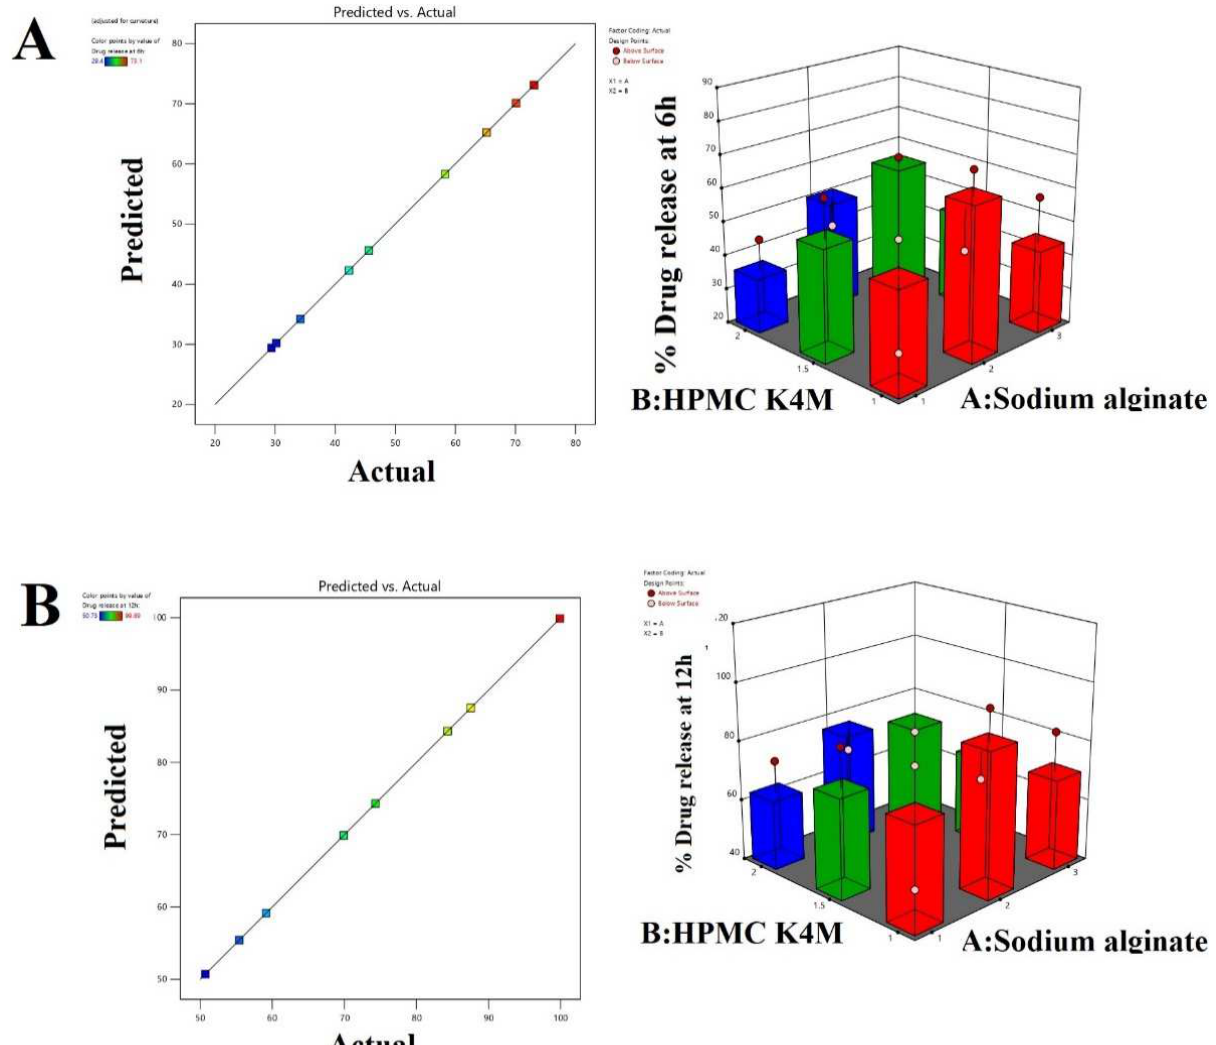
Figure 7. Predicted and actual value plots and 3D response surface plots showing the effect of the independent variables, i.e., factor A (sodium alginate) and factor B (HPMC K4M), on response % drug release at 6 h ( A ) and % drug release at 12 h ( B